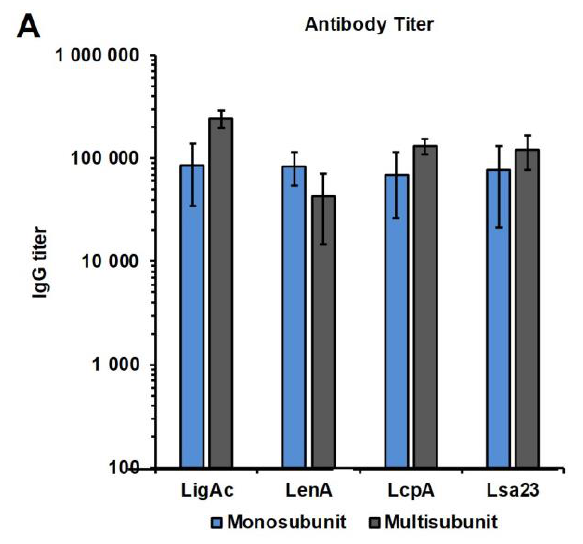
( B ) Antibody titers after immunization with pooled recombinant FHBPs as a multisubunit vaccine . The specific antibody titers to tested antigens shown (as bars) were determined by subtracting the titers for nonspecific reactivity to recombinant 6  His tag non - FHBP (recombinant LipL32) and